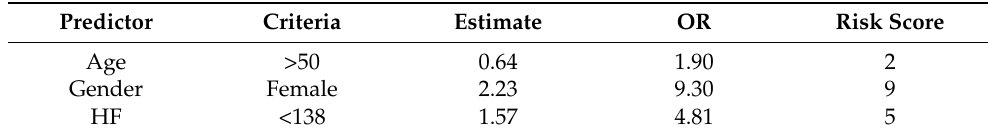
Table 3. Results of the multivariate logistic regression for the risk profile.